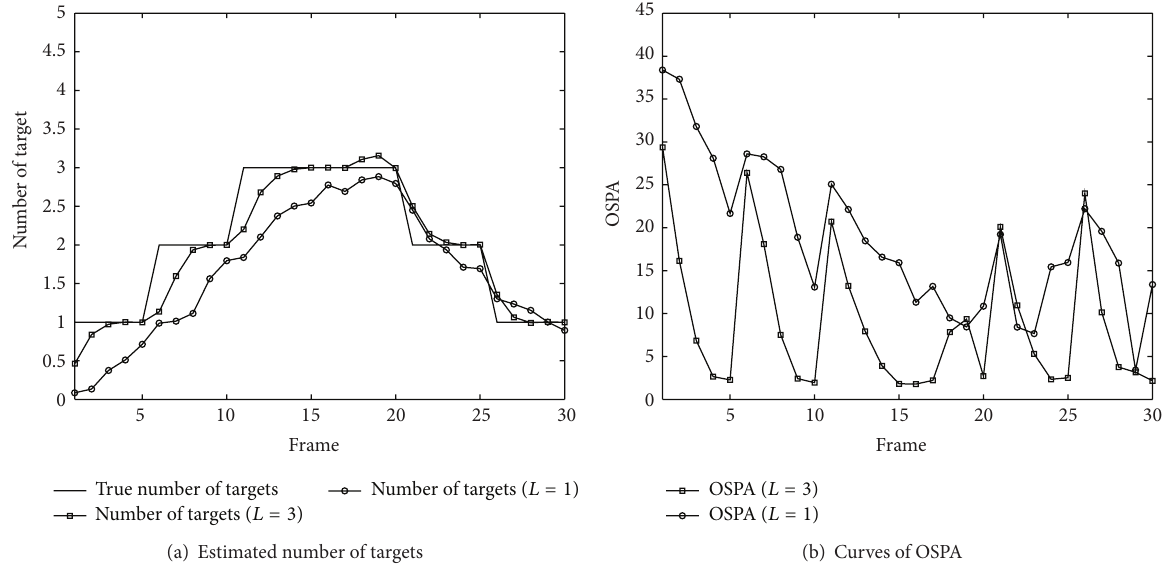
Figure 9: The estimated number of targets and OSPA (SNR = 4.8